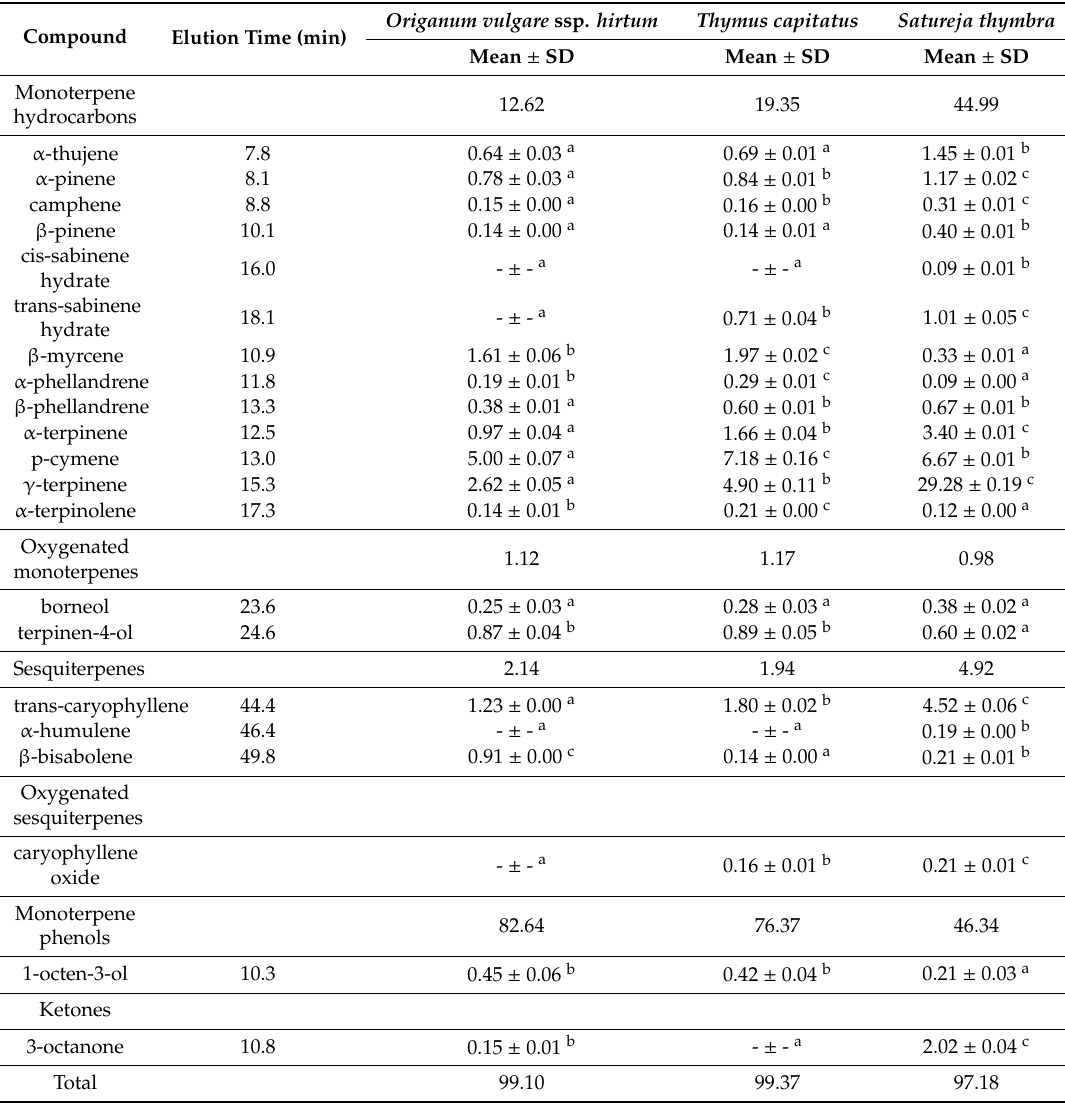
Table 1. Chemical composition (content %) of the essential oils of the three aromatic plants obtained by hydrodistillation and determined by GC / MS: Origanum vulgare ssp. hirtum , Thymus capitatus and Satureja thymbra